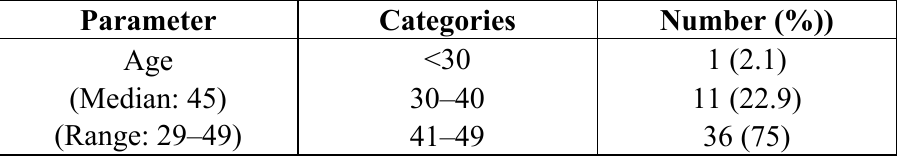
Table 1. Clinico-pathologic characteristics of patients included in the